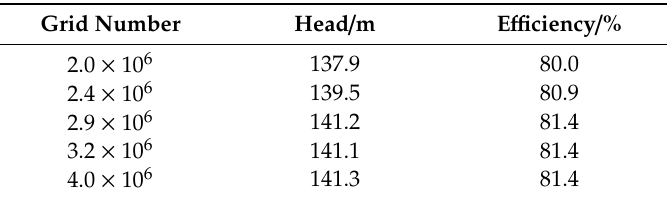
Table 2. Grid independence analysis.